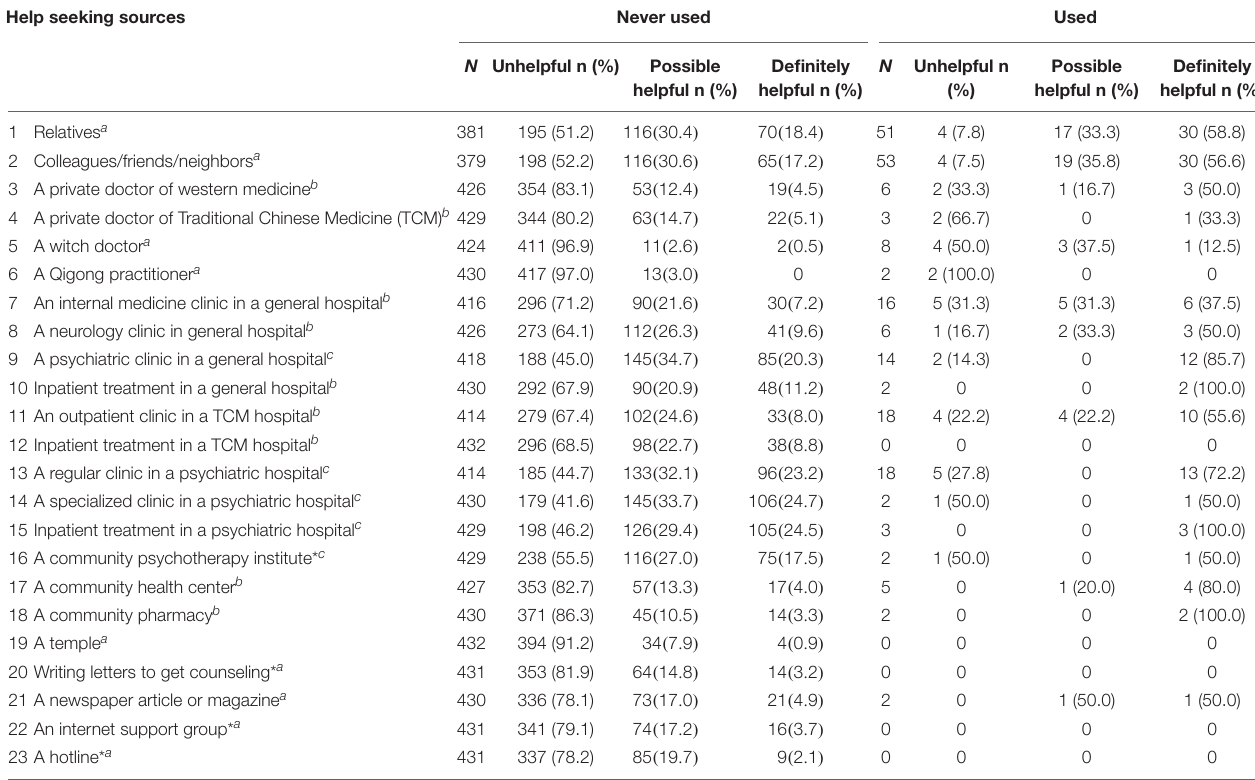
TABLE 3 | Attitudes toward helpfulness of different help-seeking sources among people with MDD who never used and ever used each